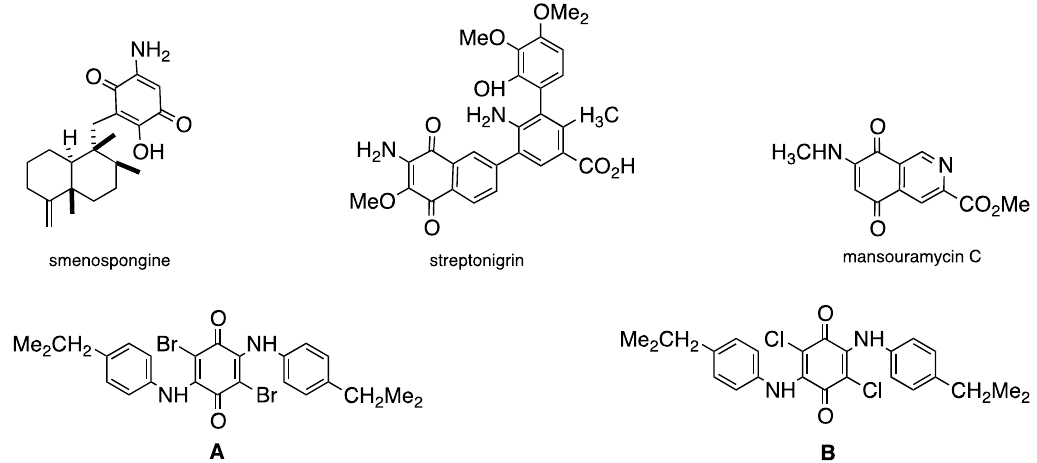
Figure 1. Examples of natural and synthetic antitumor active aminoquinones.